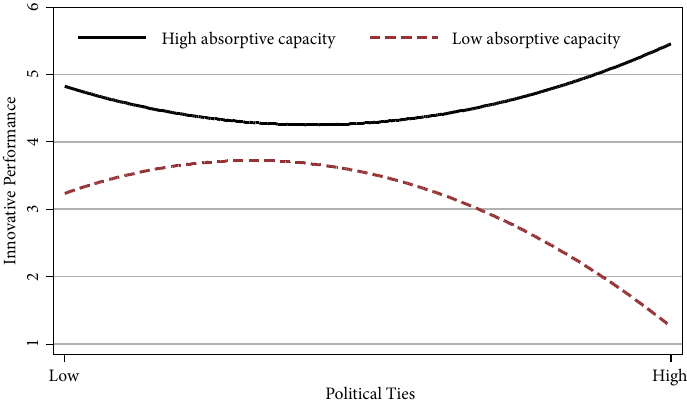
Figure 2. Curvilinear interaction of politic ties and absorptive capacity on corporate innovation